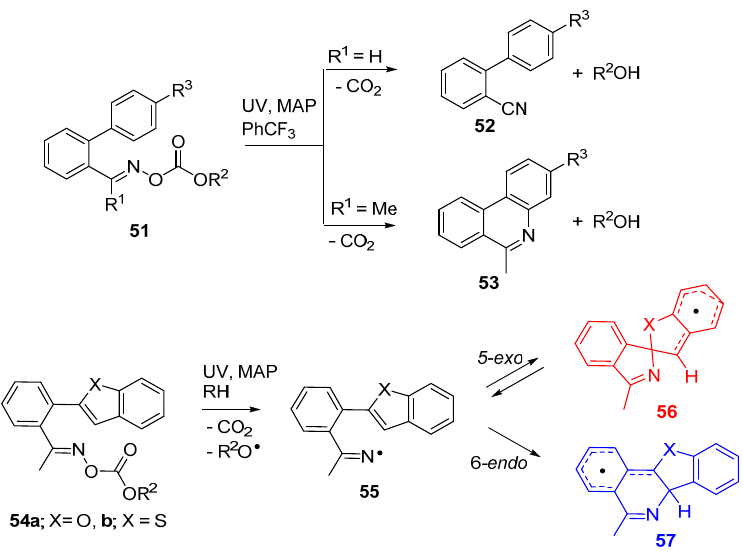
Scheme 9. Reactions of iminyl radicals derived from oxime carbonates [33,78].